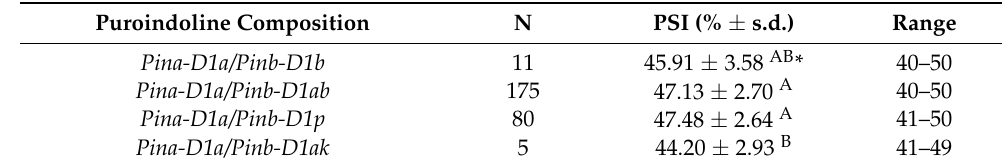
Table 2. Allelic composition for puroindoline genes and the PSI values of the lines evaluated. Puroindoline Composition N PSI (% ±